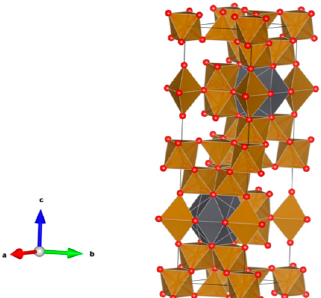
Figure 12. Magnetoplumbite. (Sr,Ba, ((Na,Cs) 0.5 +La 0.5 ))(Al,Fe) 12 O 19 . Structure hexagon.,